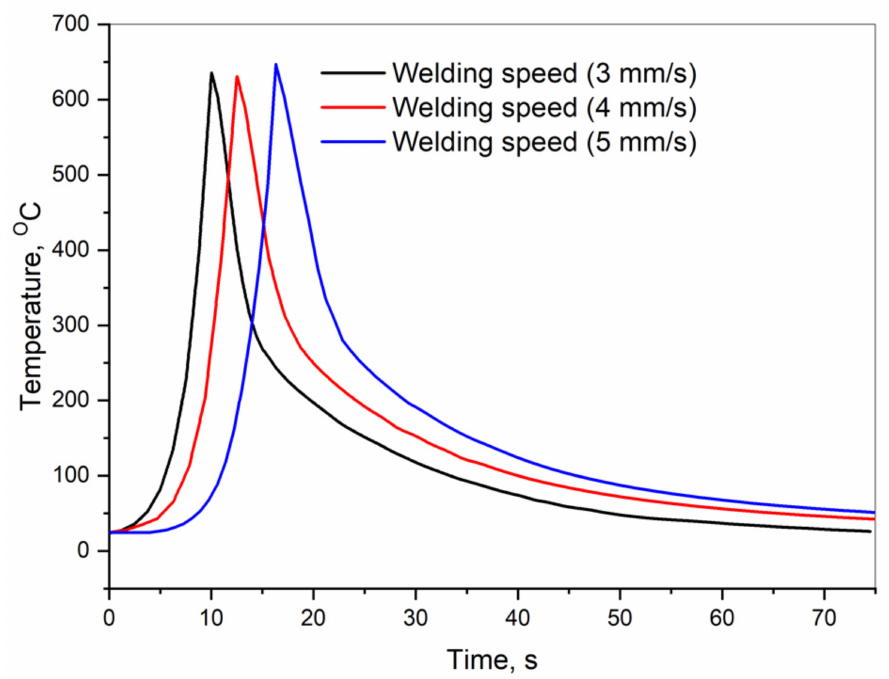
Figure 9. Temperature measurements in the centre of the fusion zone for three different welding speeds (3 mm/s, 4 mm/s, and 5